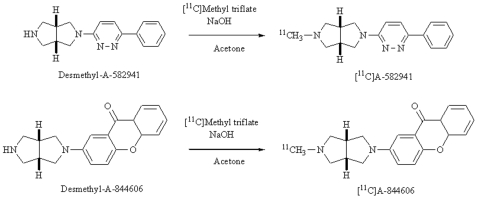
Radiosynthesis of [11C]A-582941 and [11C]A-844606.